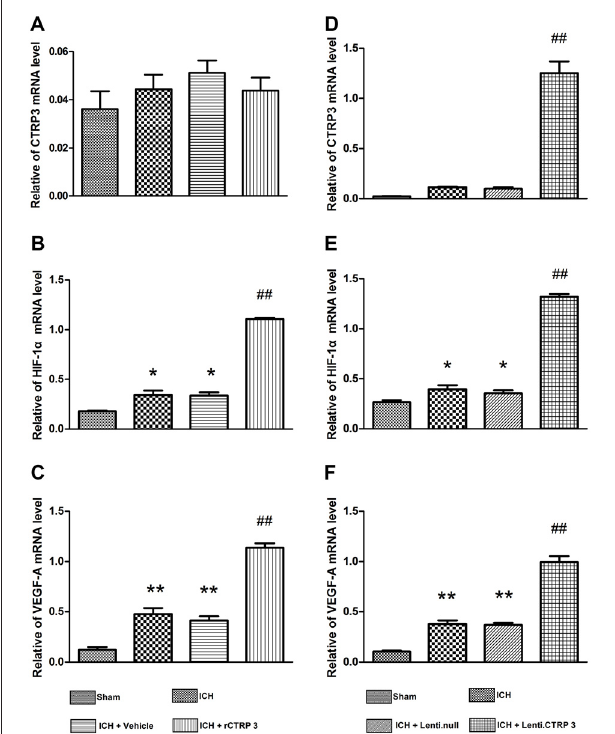
FIGURE 6 | Quantitative RT-PCR analysis of HIF-1 α and VEGF-A mRNA levels in the hematoma border zone 7 days after ICH. (A–C) Quantitative RT-PCR analysis of the effect of rCTRP3 on CTRP3, HIF-1 α and VEGF-A mRNA levels. (D–F) Quantitative RT-PCR analysis of the effect of rCTRP3 on CTRP3, HIF-1 α and VEGF-A mRNA levels. Values are mean ± SEM. n = 4–6 per group. ∗ p < 0.05 vs. sham; ∗∗ p < 0.01 vs. sham; ## p < 0.01 vs. vehicle or Lenti.null. CTRP3, C1q/tumor necrosis factor-related protein-3; rCTRP3, recombinant CTRP3; Lenti.CTRP3, Lentivirus overexpression of CTRP3; ICH, intracerebral